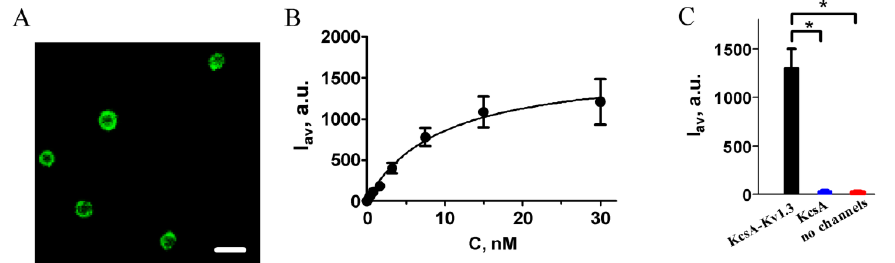
Figure 2. Interaction of GFP–MgTx with the Kv1.3 binding site. ( A ) A typical laser scanning